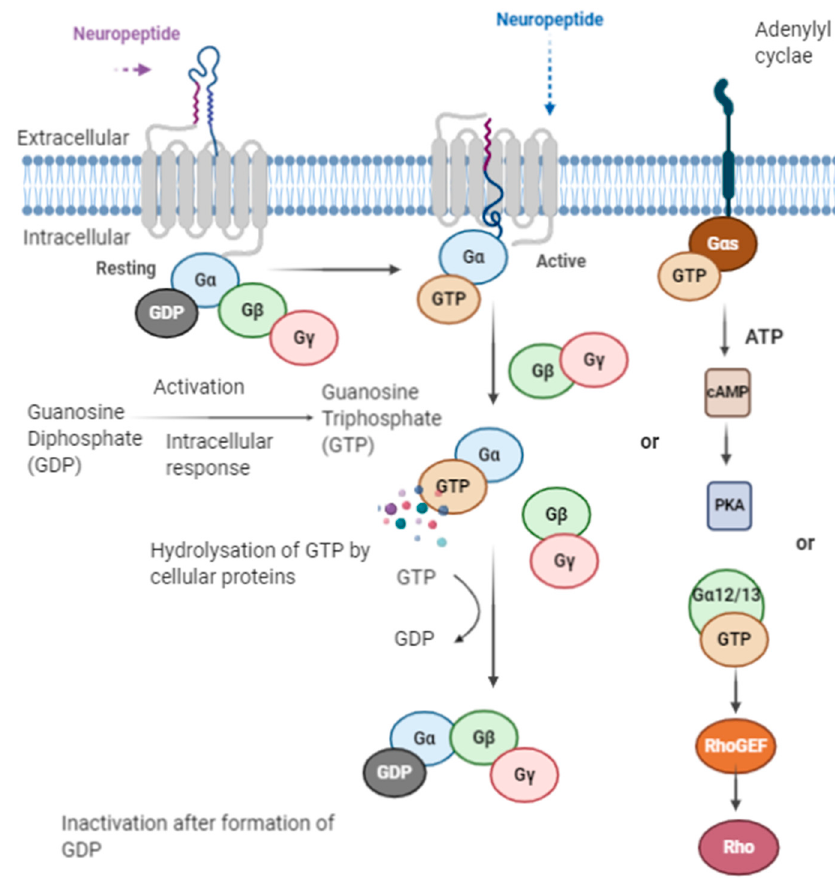
Figure 5. Mechanism of action.